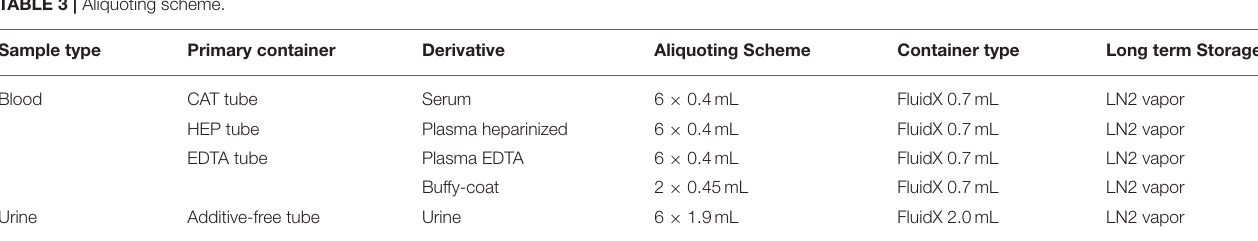
TABLE 3 | Aliquoting